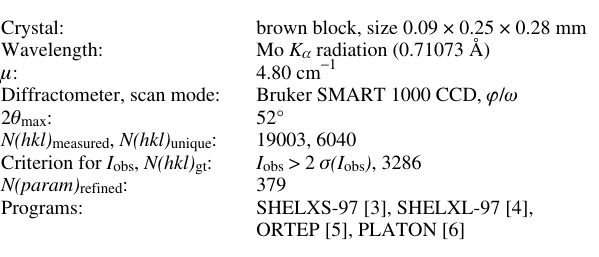
Table 1. Data collection and